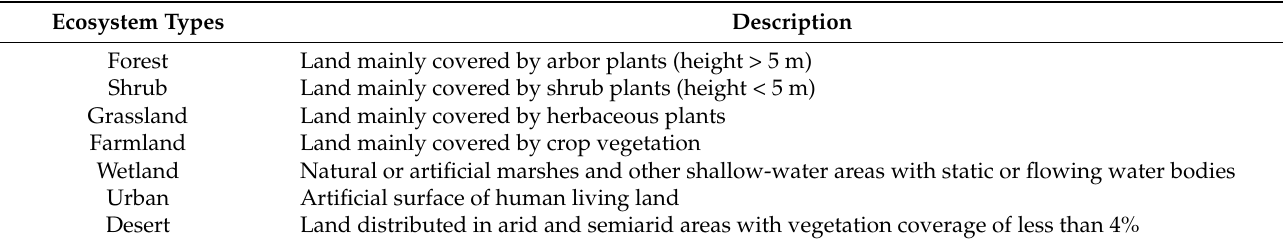
Figure 2. Flowchart of ecosystem information extraction in Loess Plateau. Table 1. The six ecosystem types with detailed